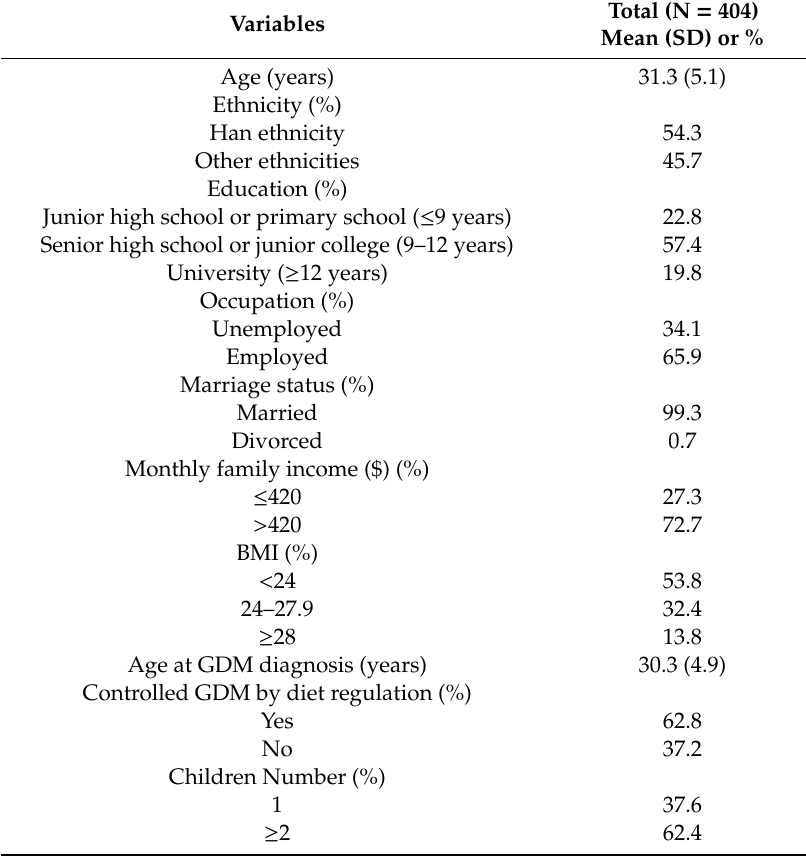
Table 2. Demographic characteristics of the study